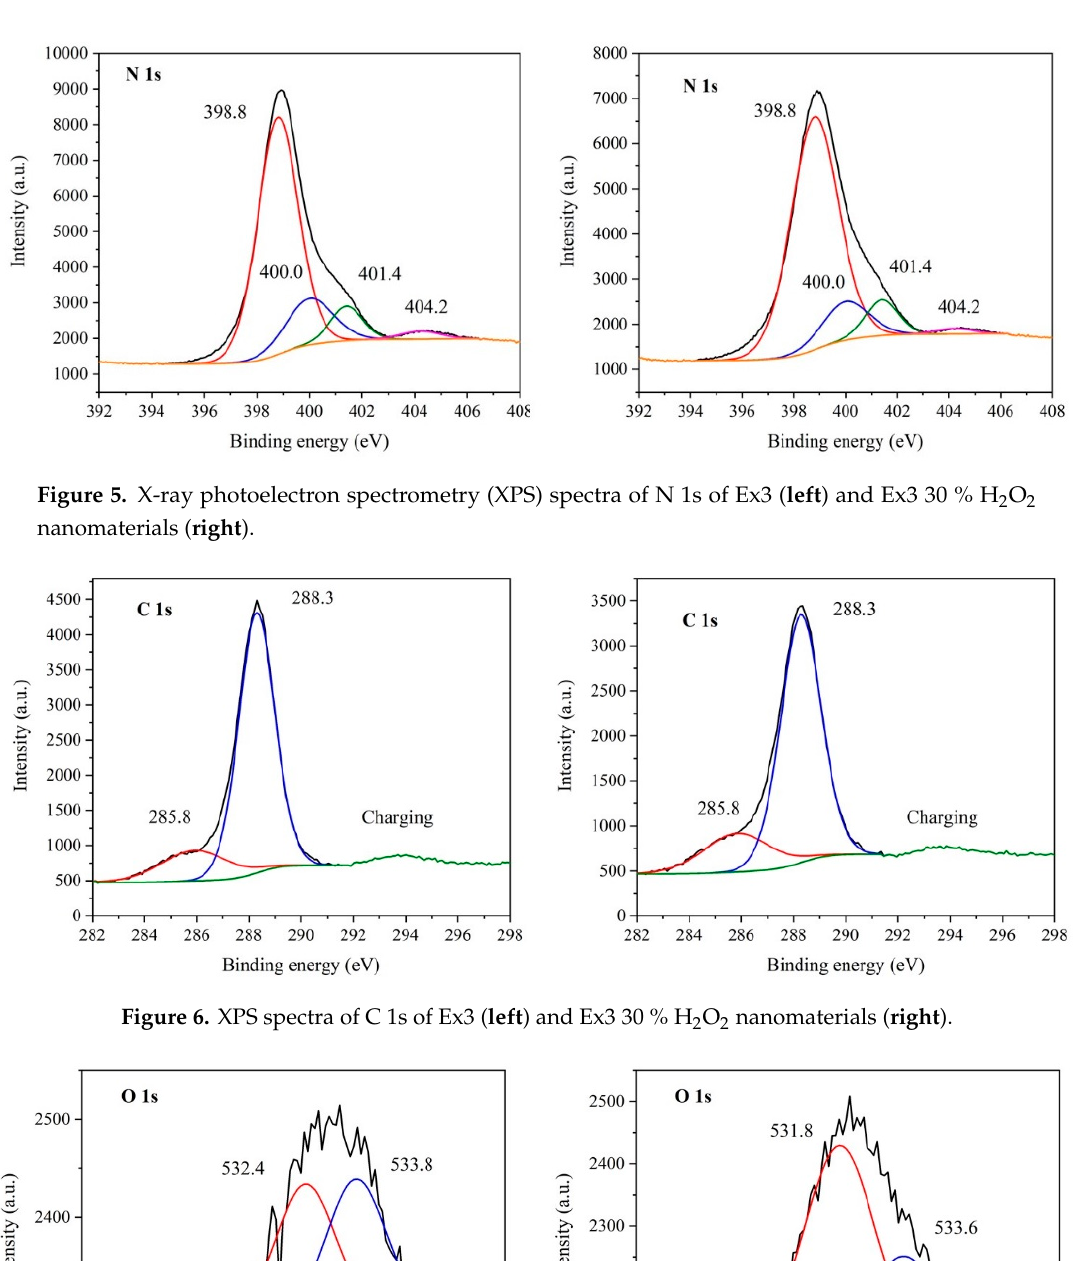
Figure 7. XPS spectra of O 1s of Ex3 ( left ) and Ex3 30 % H 2 O 2 nanomaterials ( right ).